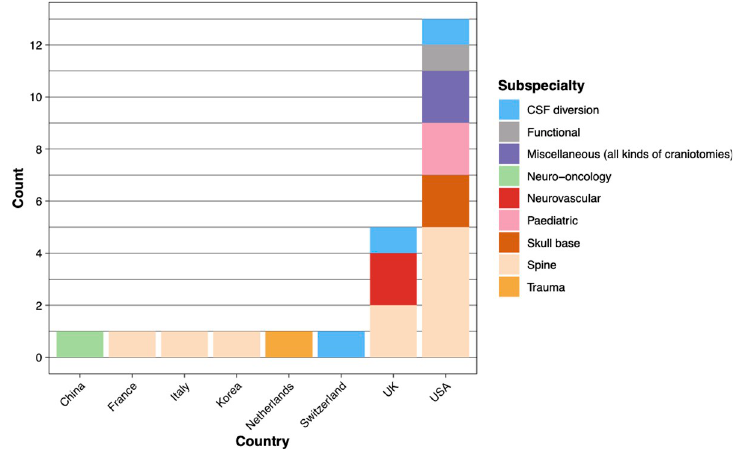
Fig 2. Country of origin and neurosurgical specialities of the included studies.